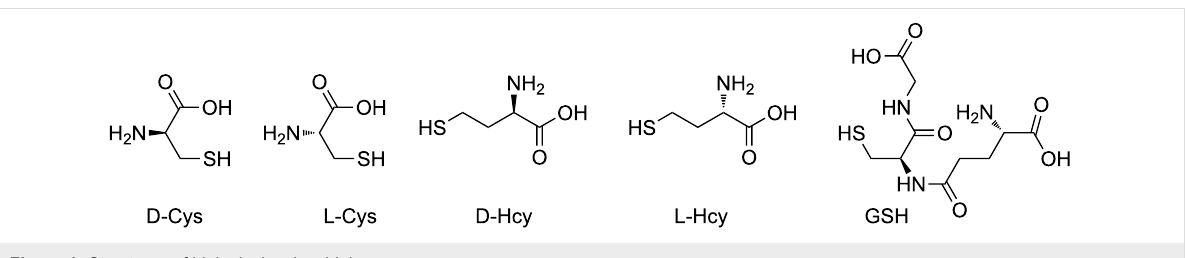
Figure 1: Structures of biological active